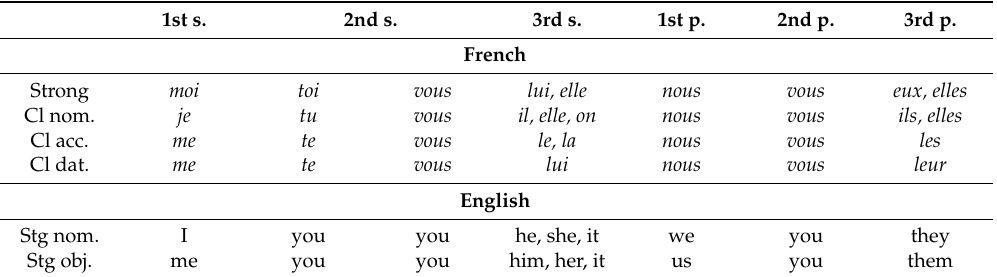
Table 1. Pronouns of English and French.